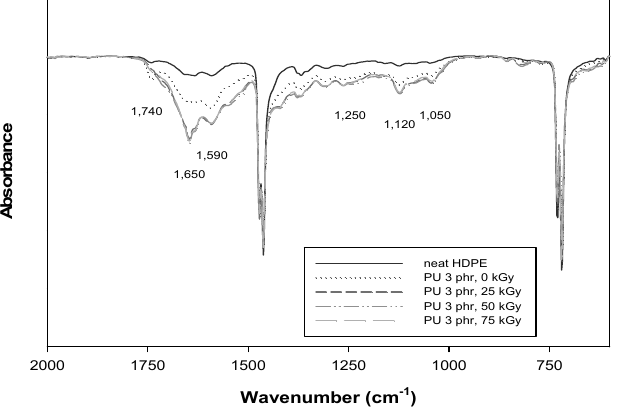
Figure 3. Fourier transformed infrared spectroscopy (FT ‐ IR) spectra of neat HDPE and irradiated PU (3 phr)/HDPE composite at various absorption doses.